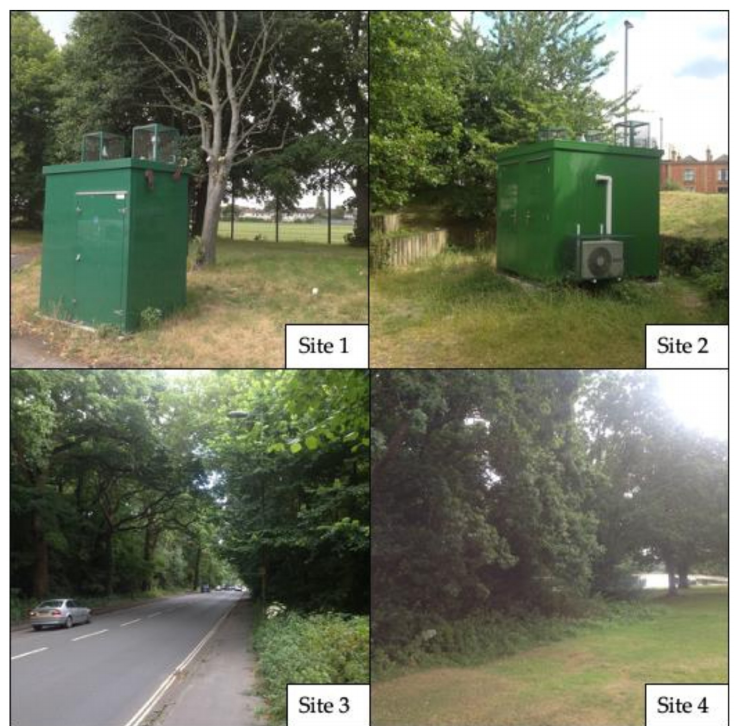
Figure 2. Images of sampling locations with Sites 1 and 2 including the automatic urban and rural network (AURN) air quality monitoring stations, Site 3 shows the high density of the vegetation surrounding the road and site as a non-roadside